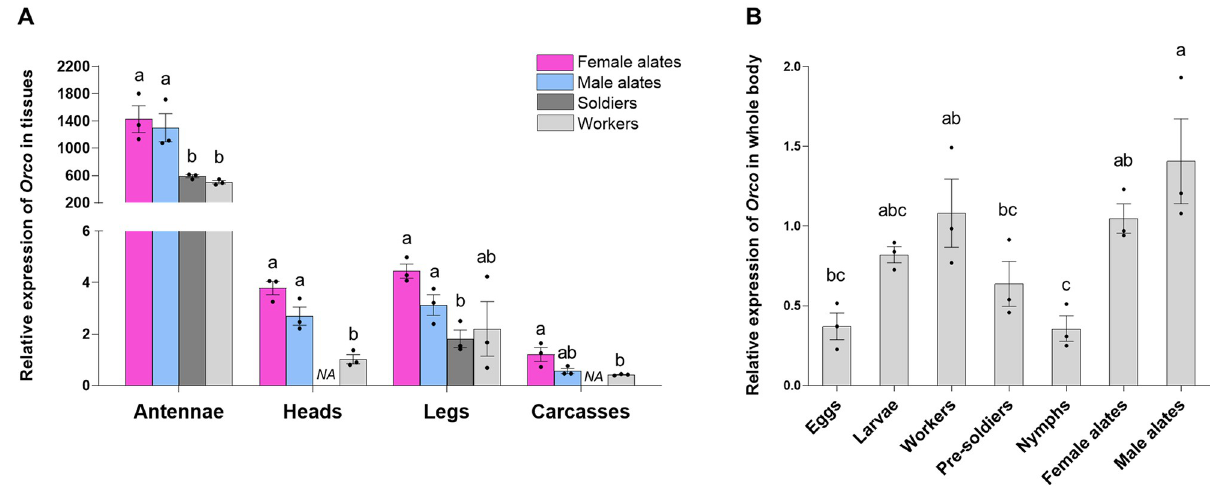
Fig 4. Spatial and temporal expression of Orco . (A) Orco expression profiles across four tissues in workers, soldiers, female and male alates. Data were comparatively analyzed among castes for the same tissue type. (B) Orco expression profiles using the whole body of termites across seven developmental stages. Different letters denote significant differences by Kruskal-Wallis followed by Dunn’s test ( P < 0.05, n = 3); NA : not available. In both graphs, bars represent means ± SE with individual data points plotted.